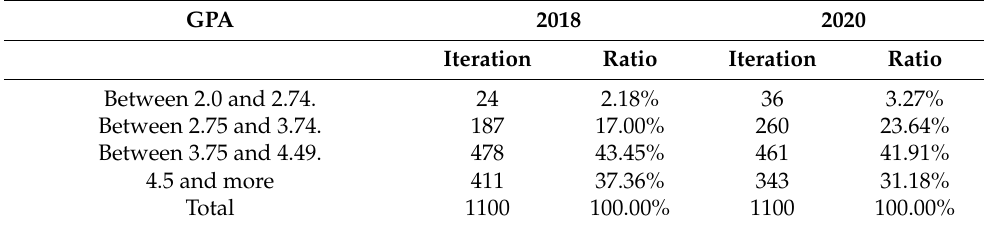
Table 6. Distribution of student numbers by academic GPA in 2018 and 2020.